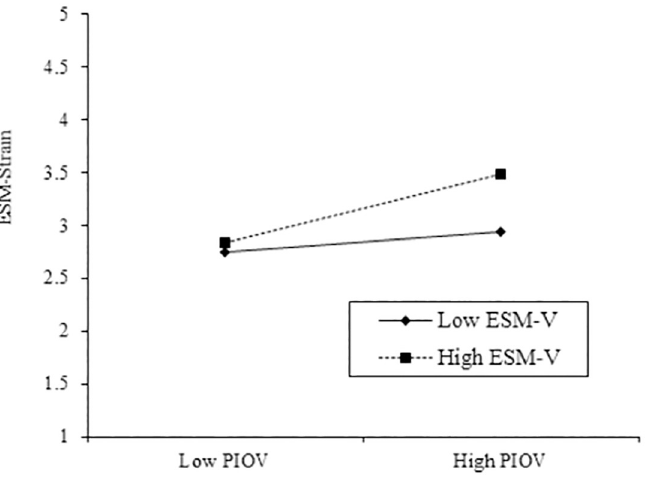
Fig 3. Moderating effect of ESM visibility in the relationship between perceived information overload and ESM- strain. Note: PIOV = Perceived Information Overload, ESM-V = ESM-Visibility.